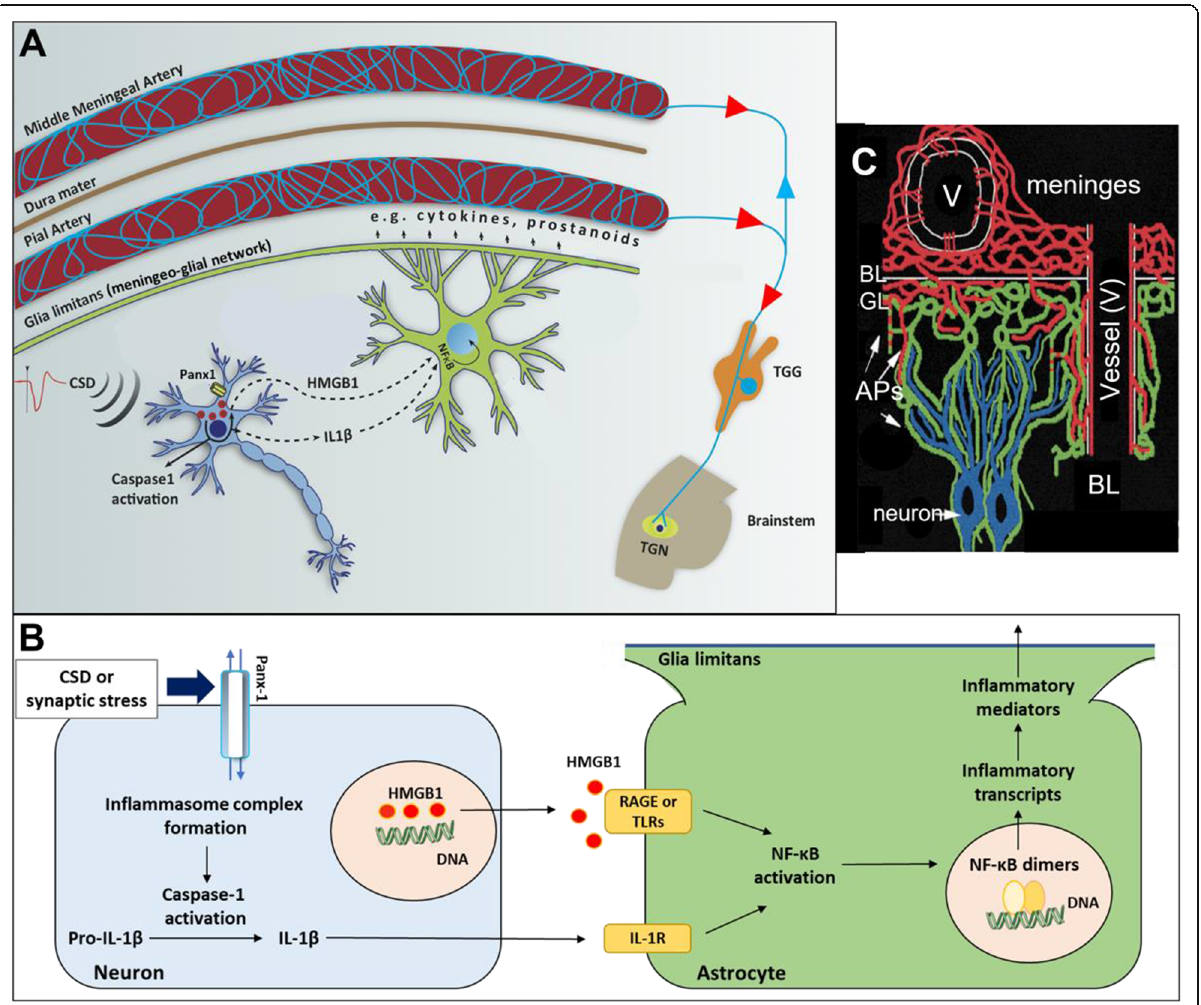
Fig. 3 Neuronal Panx1 channel opening after CSD initiates a neuroinflammatory cascade, characterized by inflammasome formation and caspase- 1 activation in neurons followed by release of HMGB1 and IL-1 β , which trigger NF- κ B nuclear translocation in astrocytes. A , B NF- κ B leads to pro- inflammatory transcriptional activity and secretion of nitric oxide, cytokines and prostanoids from astrocyte endfeet, reaching meningeal nociceptors by way of meningo-astroglial network ( C ) to stimulate them (from [2 and 100], with permission). In A, red labels show agents used to inhibit each step in the inflammatory cascade and red circles represent propidium iodide (PI) influx through open Panx1